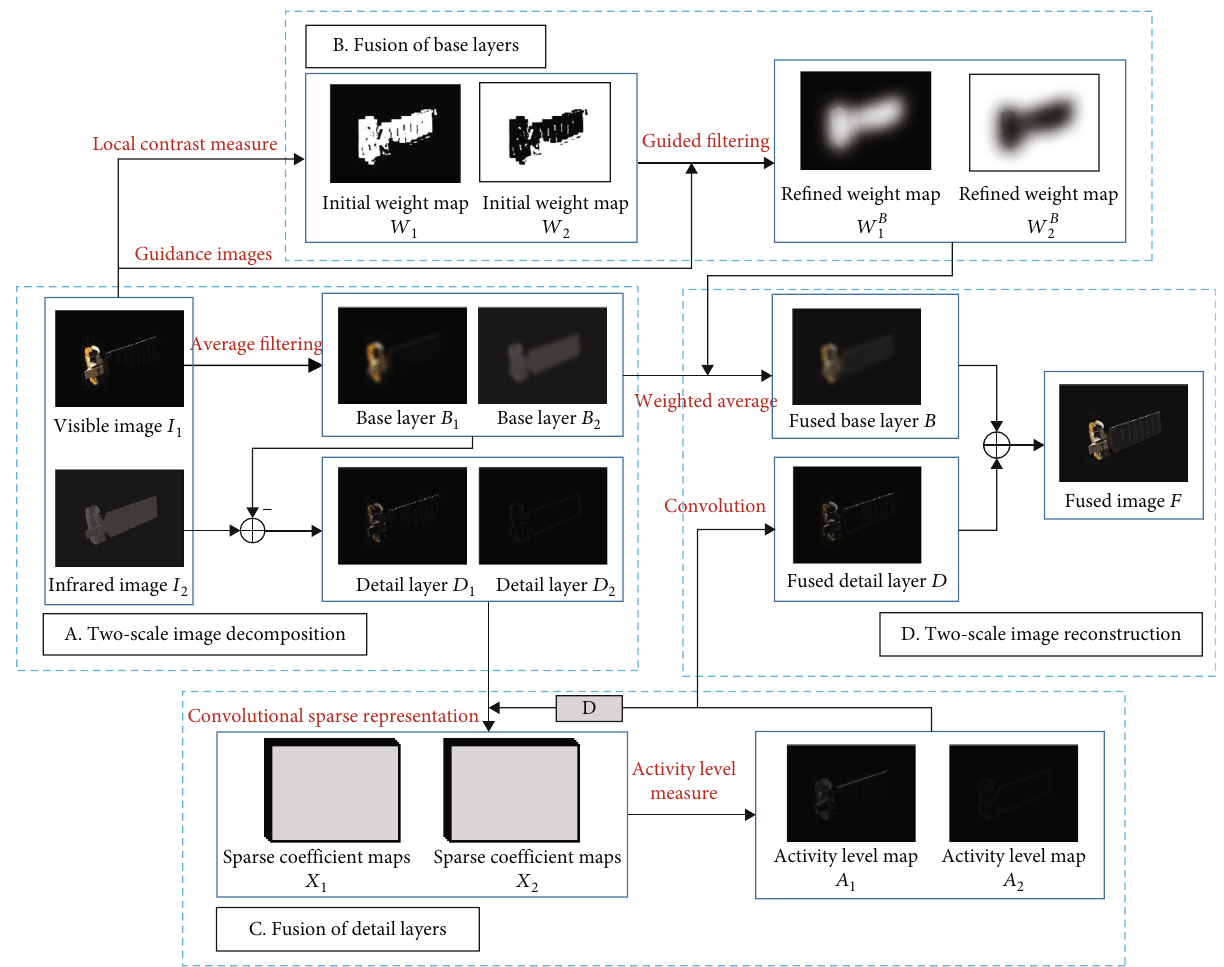
Figure 2: Overall pipeline of infrared and visible image fusion